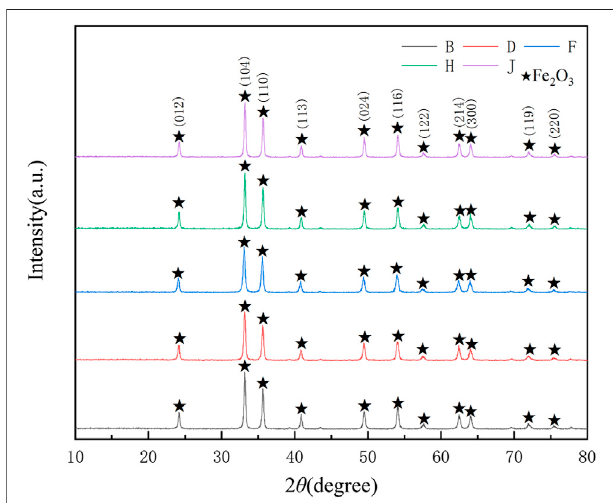
FIGURE 9 | SEM images of the pyrolysis products (A) 1:0.5 (B) 1:1 (C) 1:1.5 (D) 1:2 (E) 1:2.5.